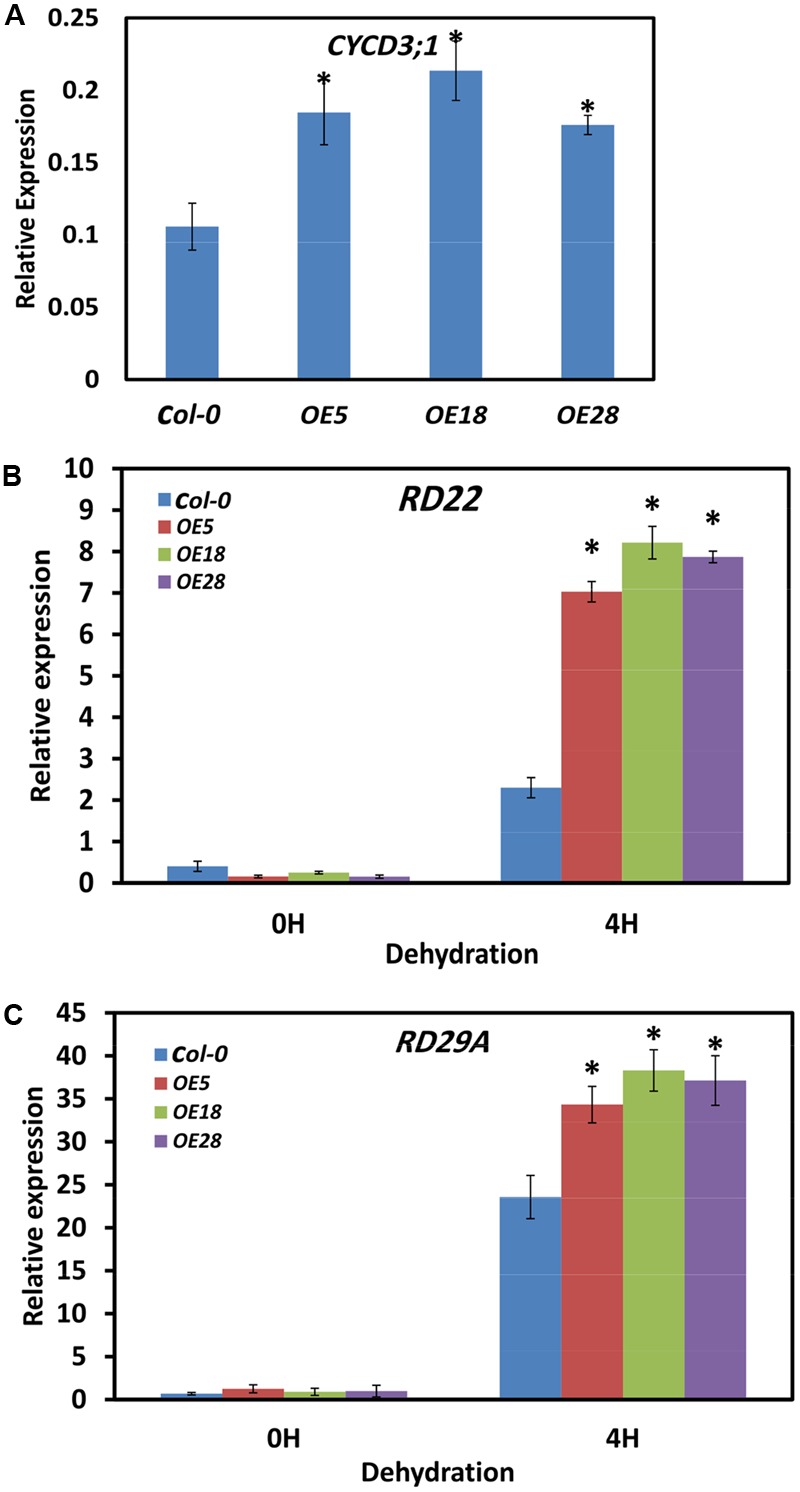
HbEBP1 overexpression promoted the expression of CYCD3;1, RD22 and RD29a in Arabidopsis. (A–C) Quantification of expression of (A)
AtCYCD3;1, (B)
AtRD22 and (C)
AtRD29a by Q-PCR in the Col-0, OE5, OE18 and OE28 plants. For the dehydration treatment, the detached leaves were subjected to dehydration under the controlled condition for 4 h. Total RNA was extracted from 2-week-old seedling samples and Q-PCR was performed with gene-specific primers as listed in Supplementary Table S1. The transcript levels were normalized to that of ACTIN7. Two micrograms of total RNA was used for each sample analysis, and the data are presented as mean ± SEM from three biological replicates. An asterisk (∗) indicates a significant difference (p < 0.05) between the HbEBP1 OE lines and Col-0 in (A), or between the HbEBP1 OE lines and Col-0 after 4 h of dehydration treatment in (B,C). Significance was determined by Student’s t-test at the probability levels of p < 0.05.